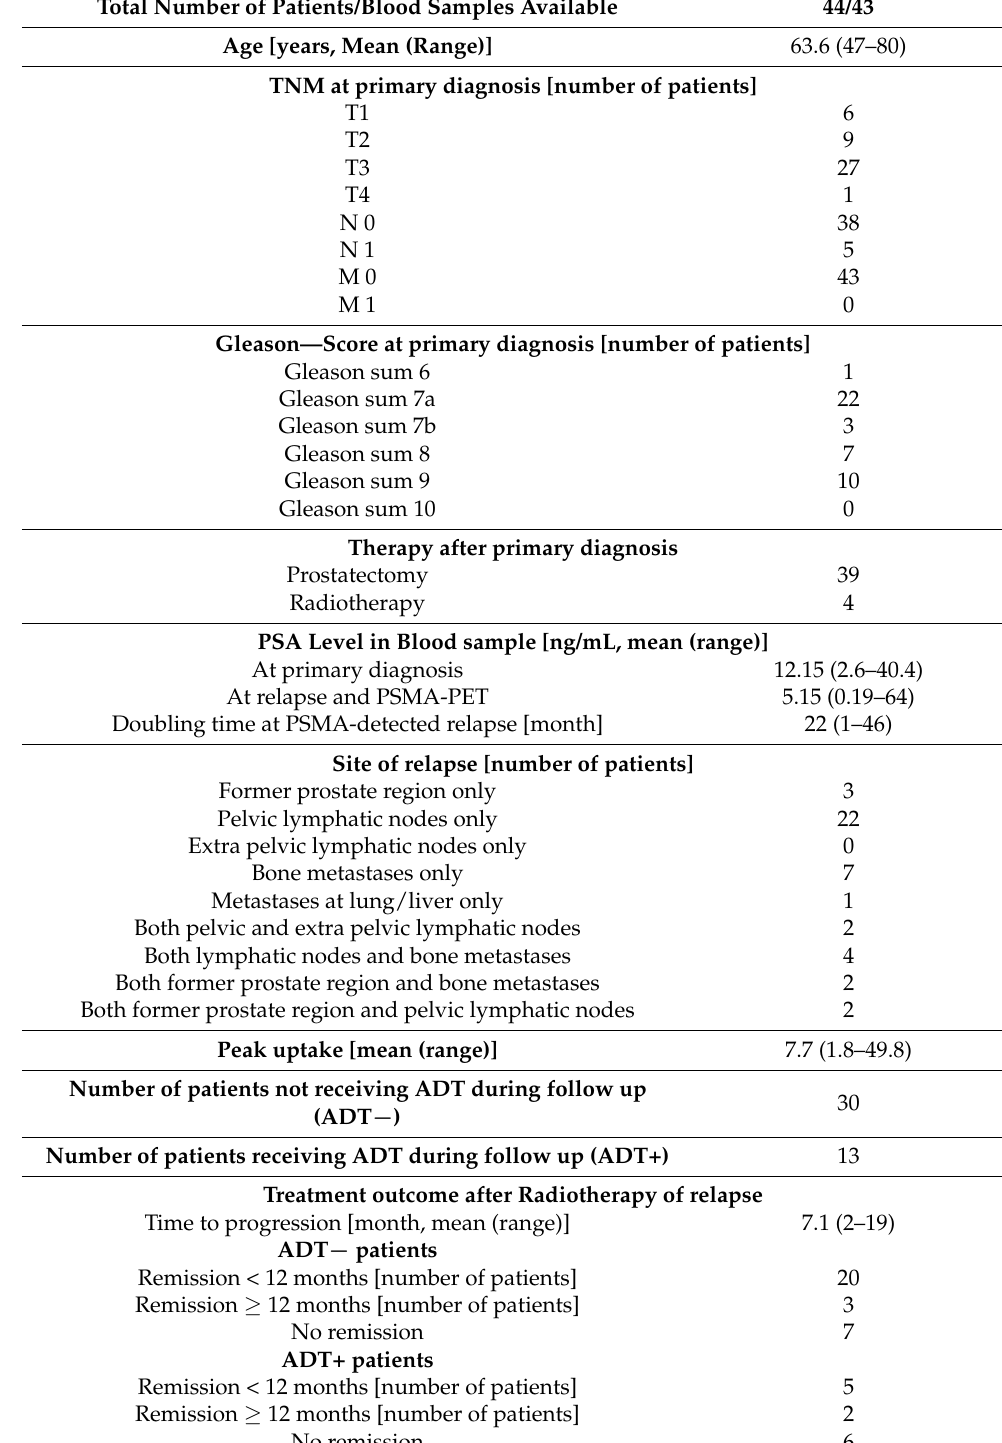
Table 1. Patients’ characteristics. Total Number of Patients/Blood Samples